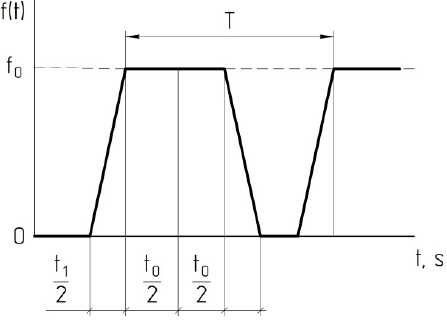
Figure 4. Trapezoidal modulation function of the rotor pneumatic system.